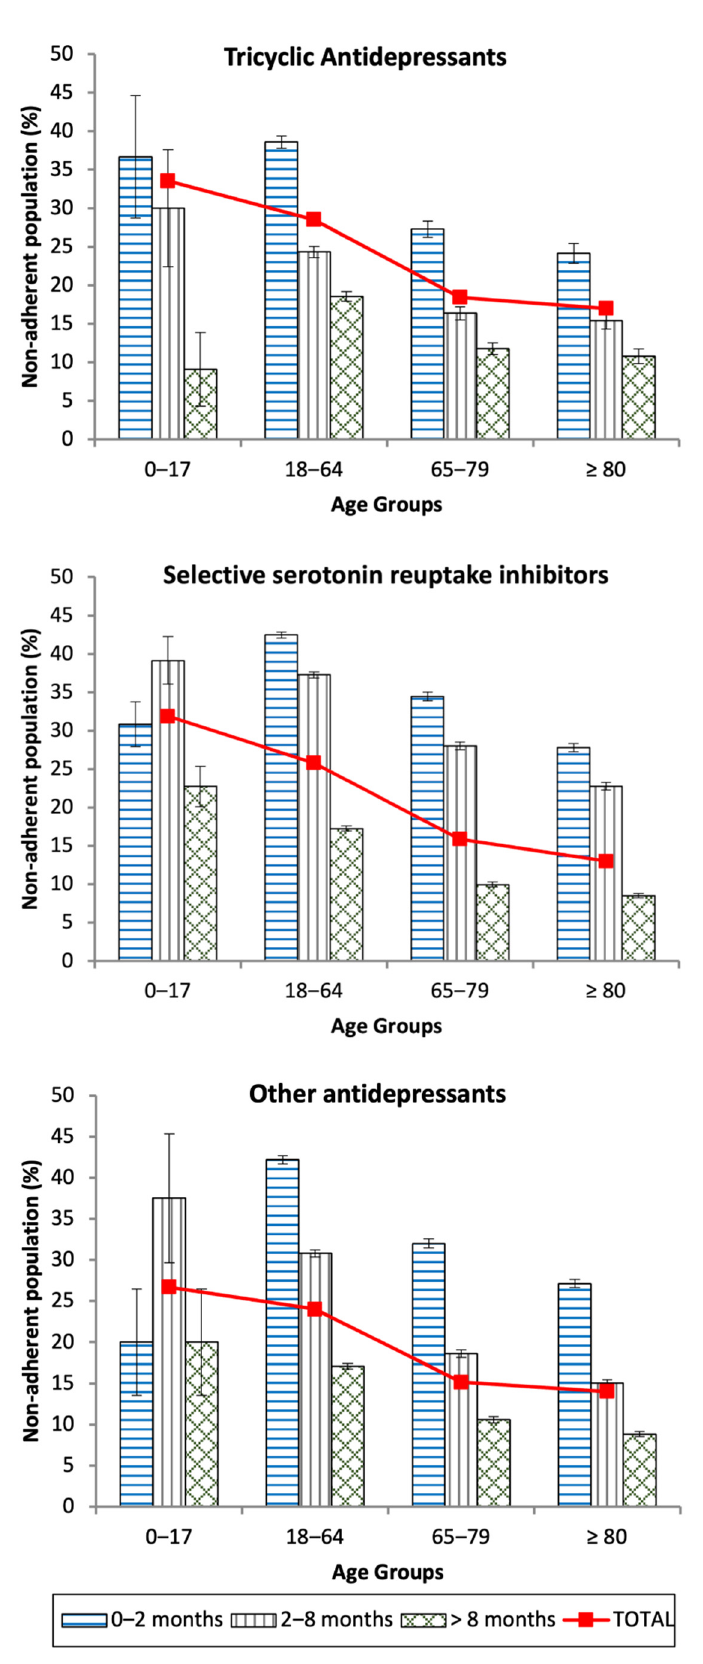
Figure 1. Antidepressant non-adherence prevalence among the Castile and Leon (Spain) population by length of treatment and age groups.